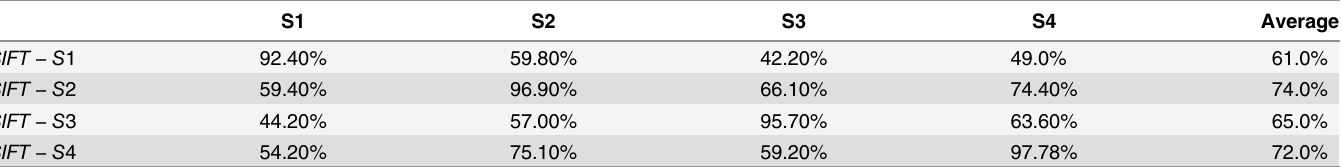
Table 1. Confusion matrix.